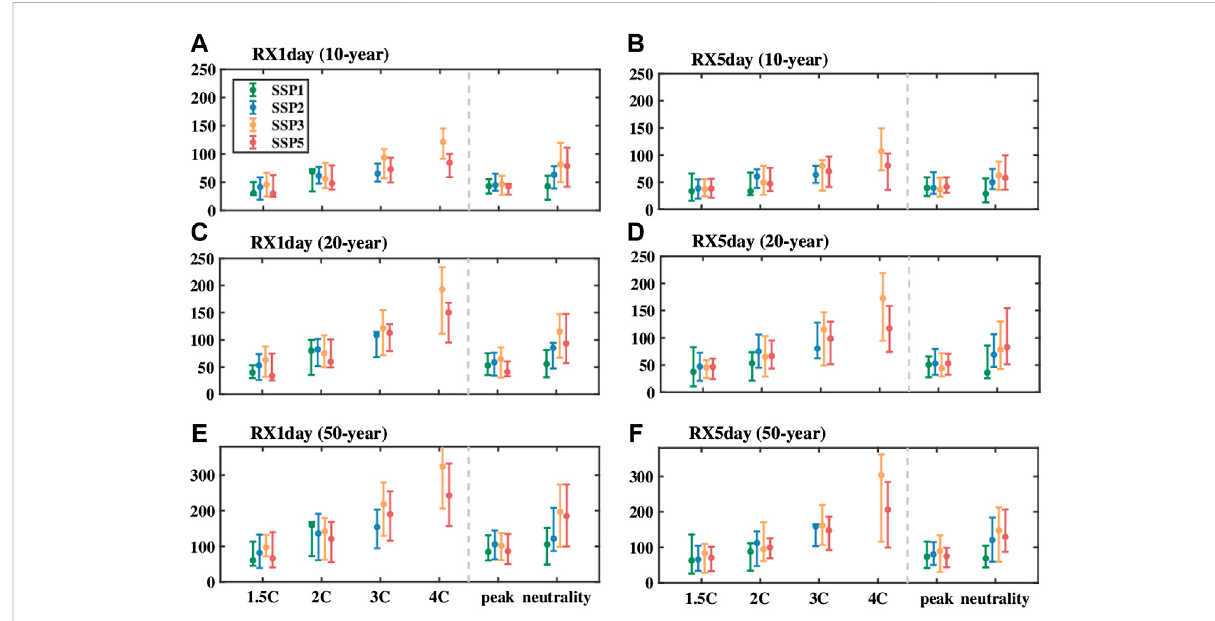
FIGURE 7 Projected changes in areal-mean aggregated population exposure to (A) , (B) 10-year, (C) , (D) 20-year and (E) , (F) 50-year RX1day and RX5day over China under the 1.5 – 4.0 ° C warmer climate as well as the carbon peak (2030) and neutrality periods (2060) under all the four SSPs. The data points and error bars represent the MMEs and interquartile model spreads, respectively. Units: